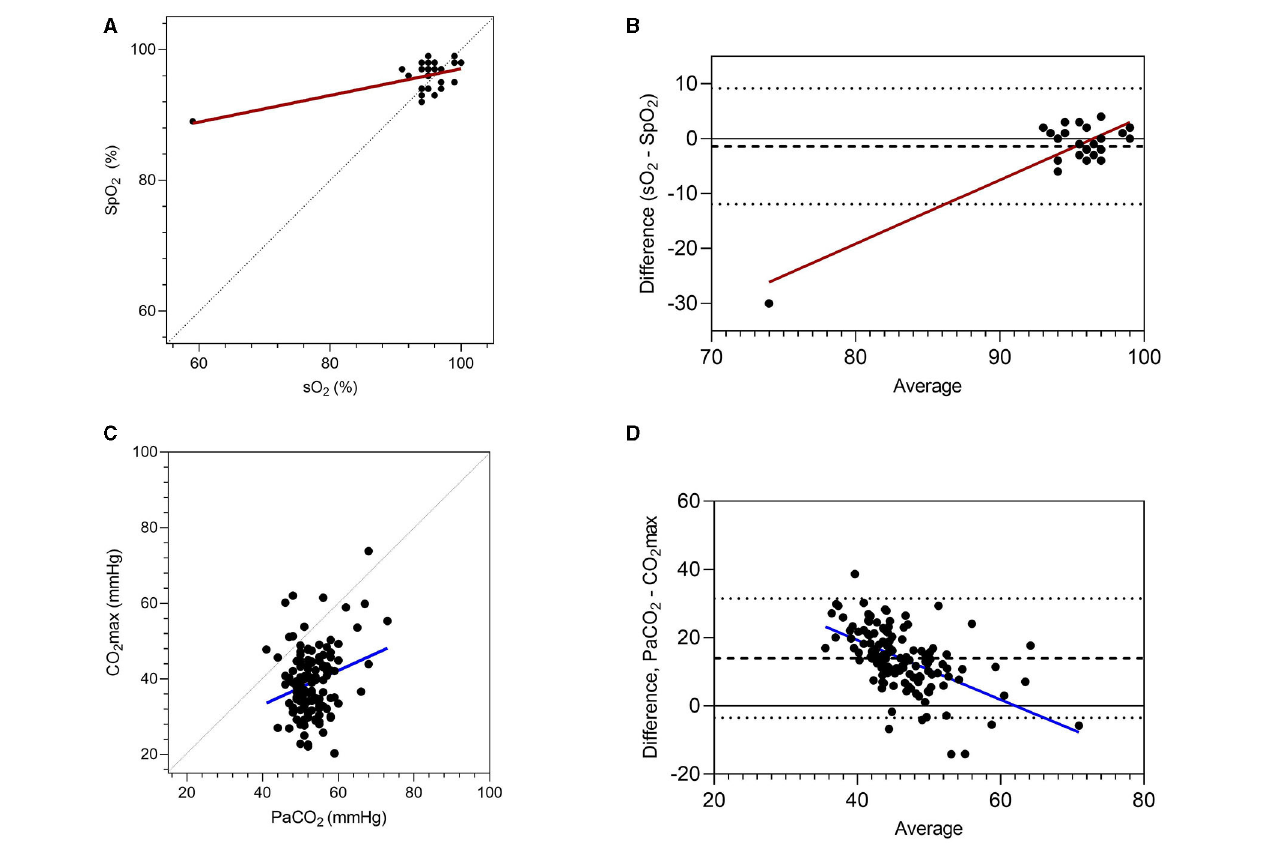
FIGURE 3 | Associations between blood gas results and non-invasive measures of oxygenation (pulse oximetry, SpO 2 ) and carbon dioxide accumulation (CO 2 max). Results are presented as correlations (A,C) , with perfect agreement (unity) shown as a dotted line. Agreement is shown following Bland-Altman analysis (B,D), with the mean difference (dashed line) and limits of agreement (dotted lines) shown. Oxygenation of hemoglobin (sO 2 ) and partial pressure of CO 2 (PaCO 2 ) were determined from blood gas analyses.